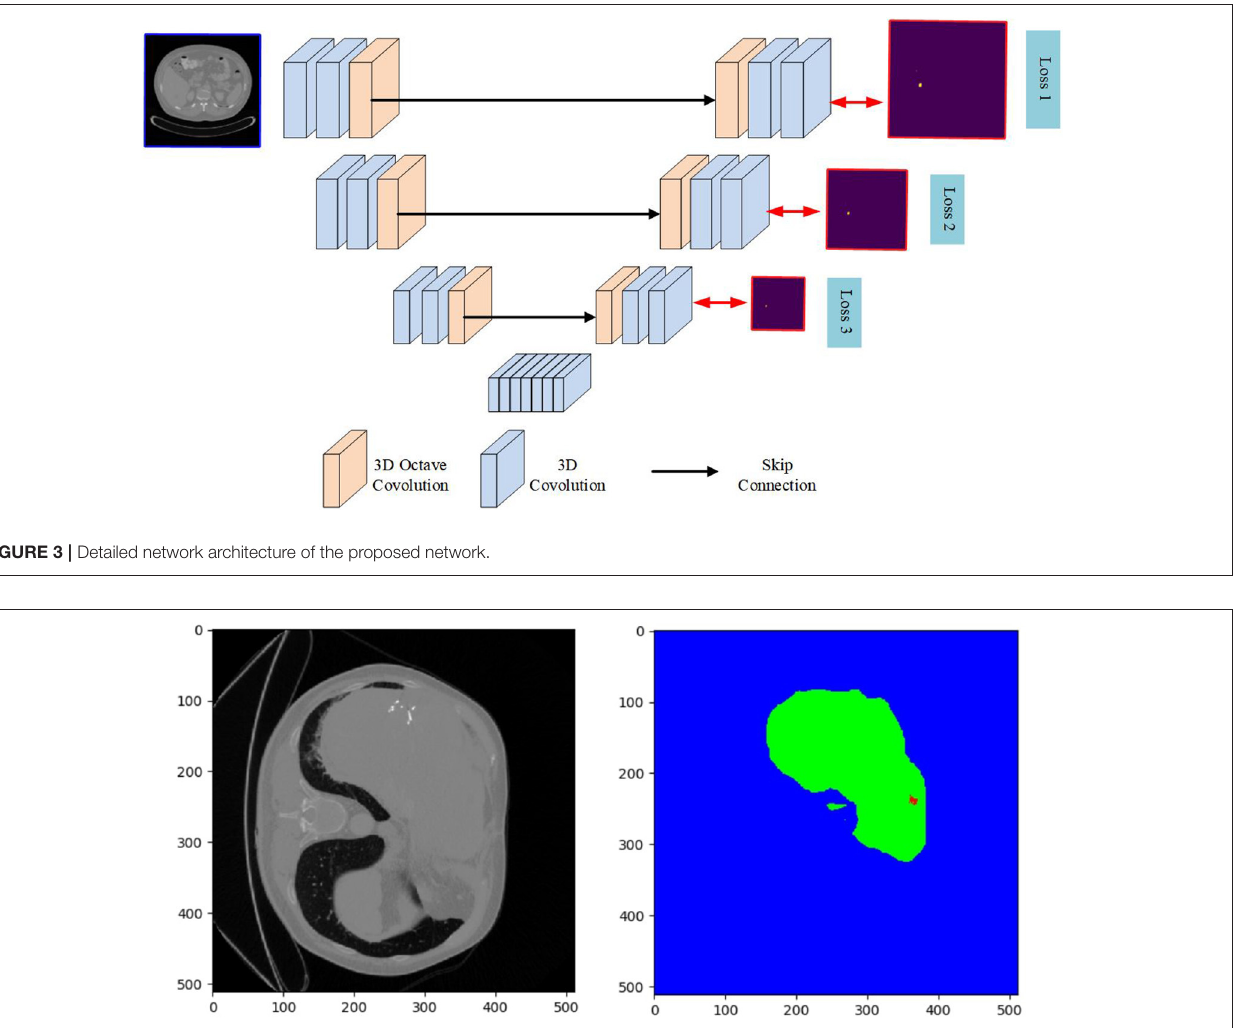
FIGURE 4 | Training data provided by